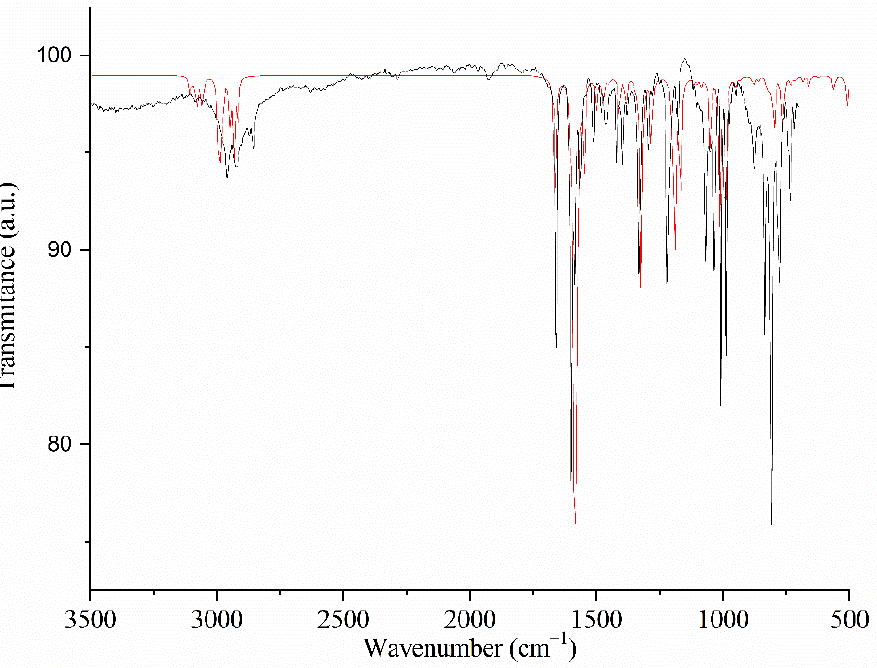
Figure 2. IR Overlay for FT-infrared spectrum of BBP in black and FT-theoretical vibrational frequencies in red.